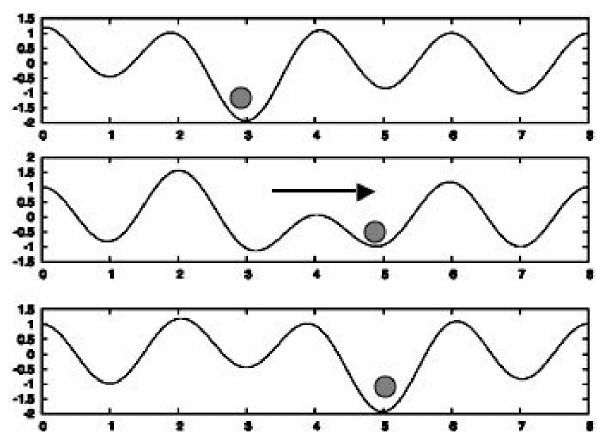
Fig. 11. The effect of the perturbing potential 8(x − vt) . From the top to the bottom, the particle can flip only in the positive x- direction as the potential travels. The flip occurs only for a suitable combination of v and the noise amplitude σ .